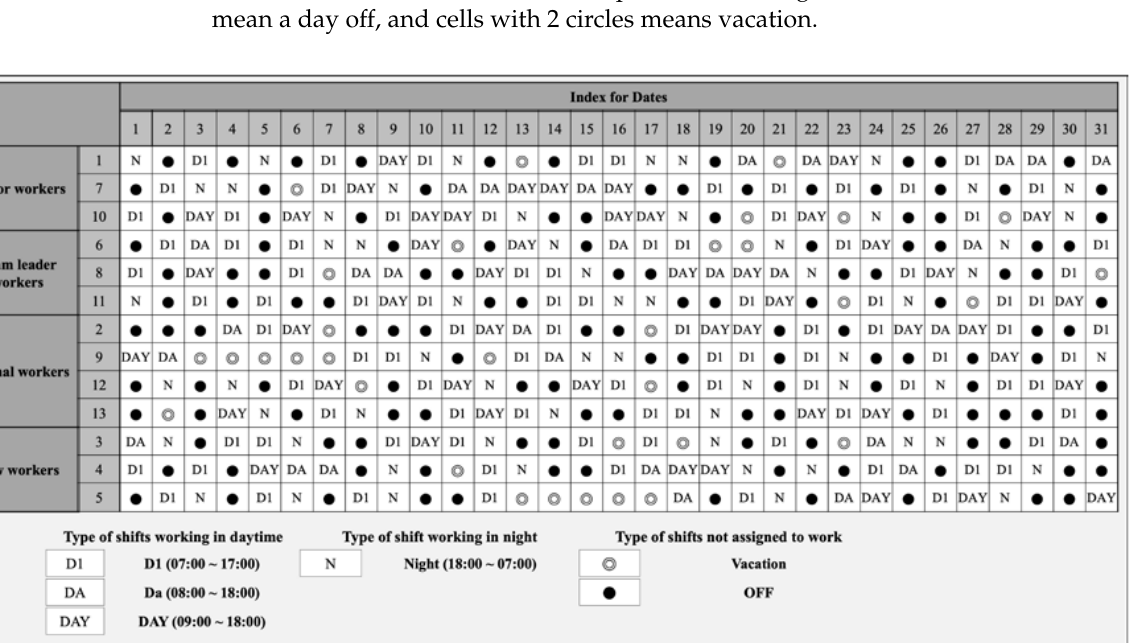
Figure 3. A staff scheduling using conventional